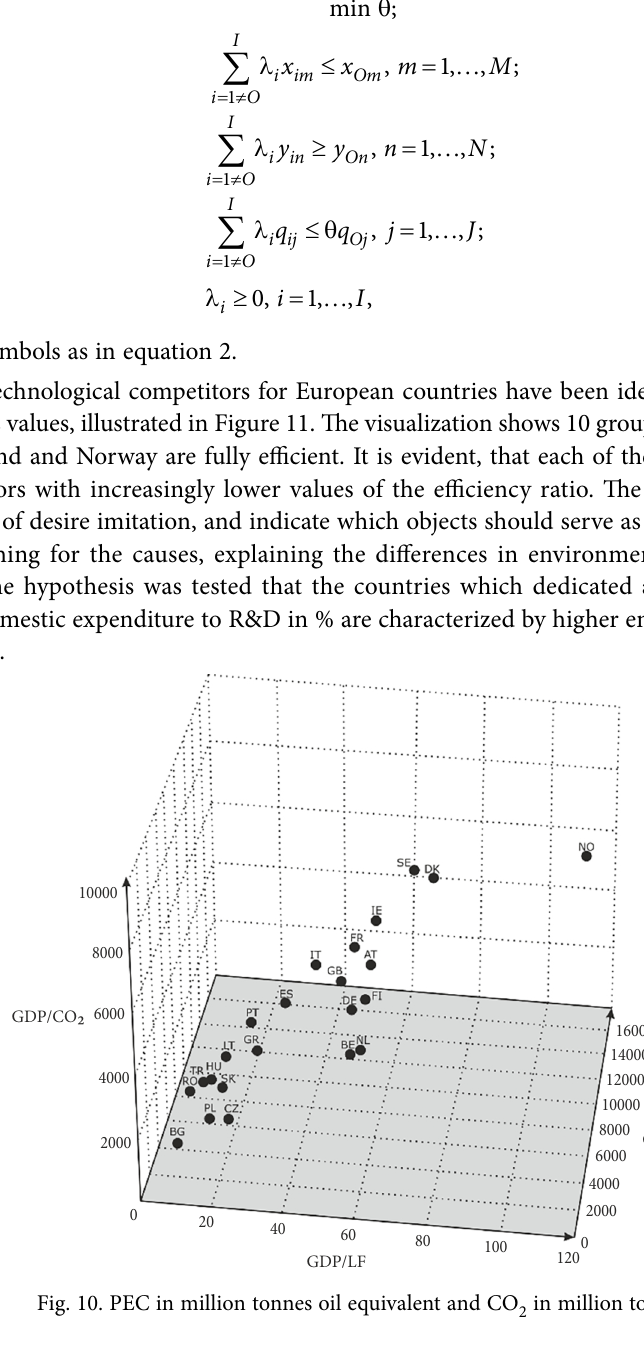
Fig. 10. PEC in million tonnes oil equivalent and CO